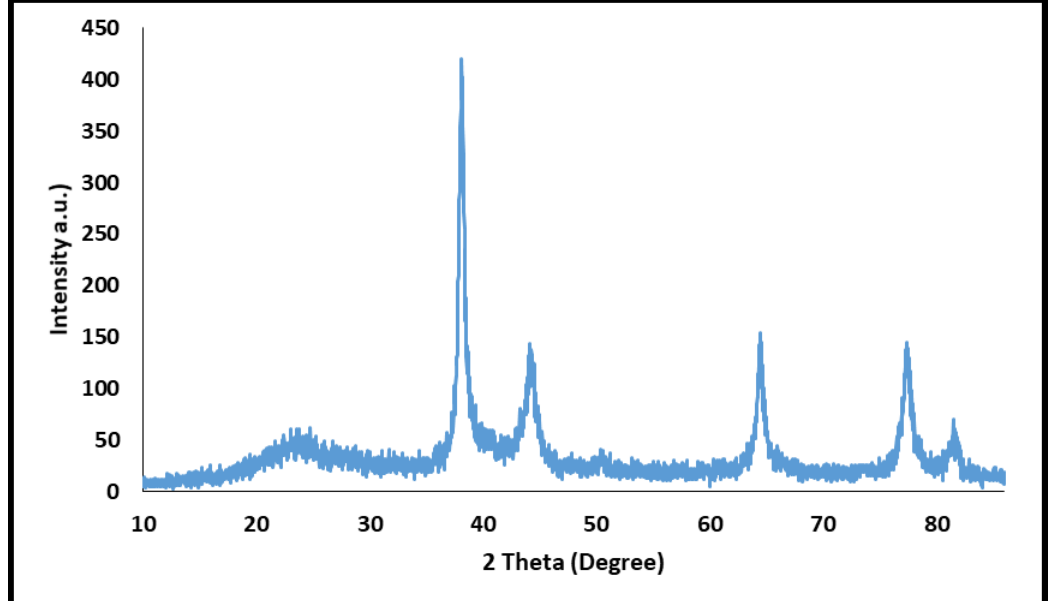
Figure 5. XRD pattern of the catalyst.